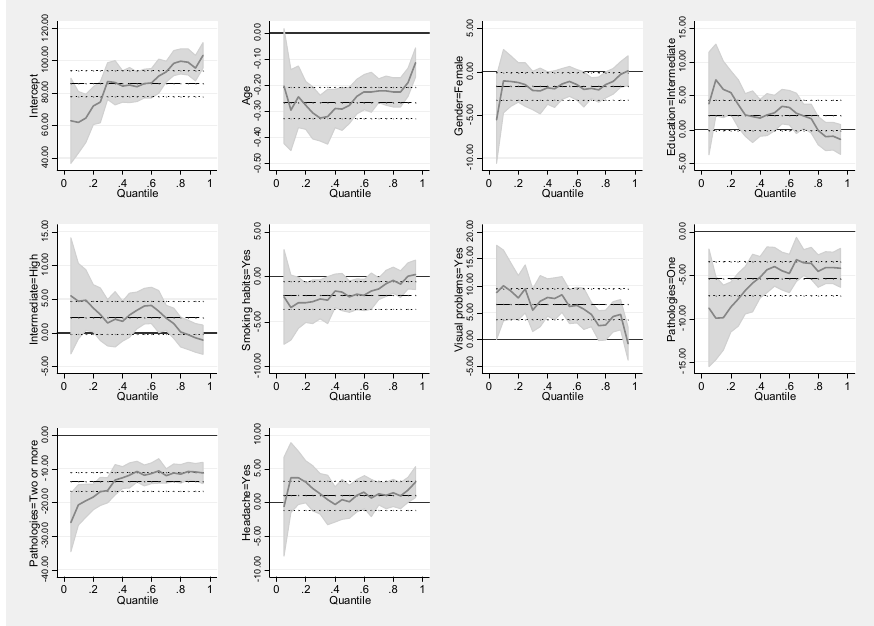
Figura 4 – Point estimates and 95% confidence intervals from a quantile regression of the EQ-5D VAS